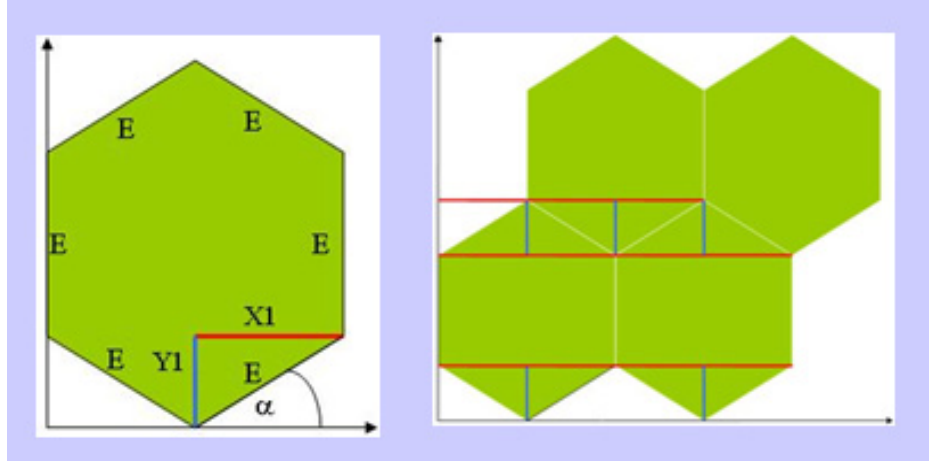
Figure 2. Schematic representation of basic geometrical elements used.